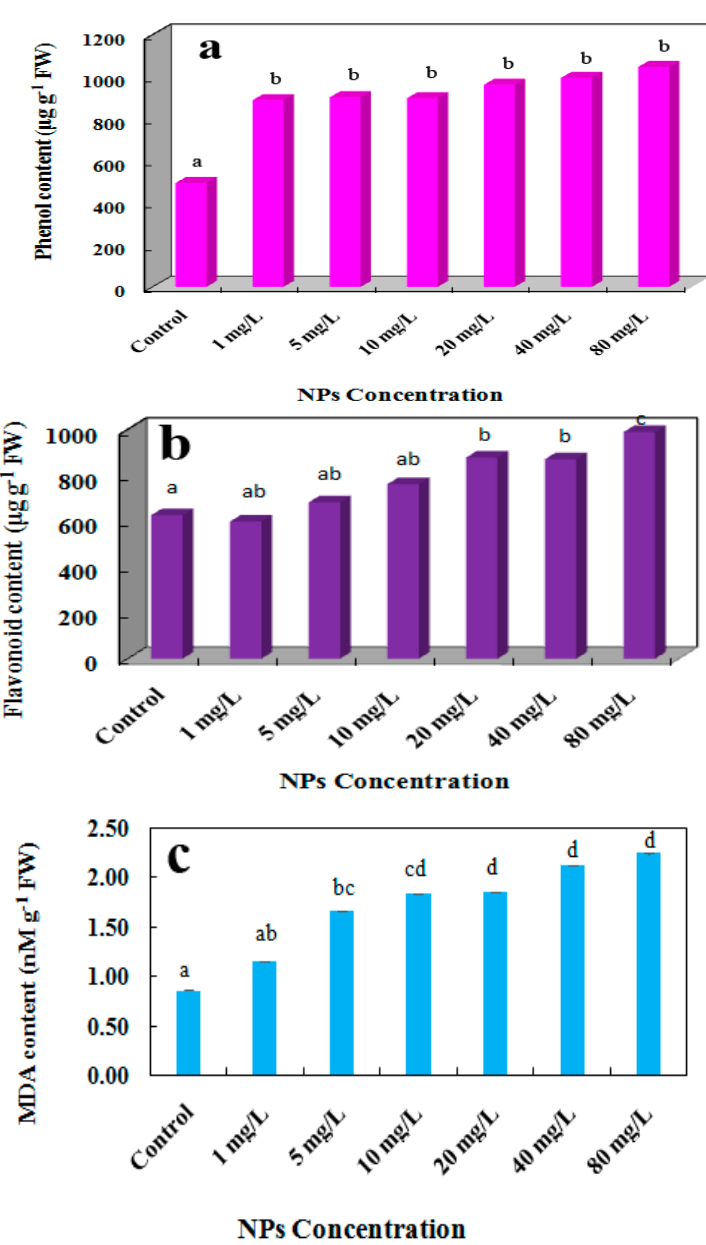
Figure 6. Impact of CdSe NPs on total ( a ) phenol, ( b ) flavonoid, and ( c ) MDA content, respectively. The differences are significant. The level of significance is determined at p ≤ 0.05 according to Tukey Test ( n = 3 replicates).